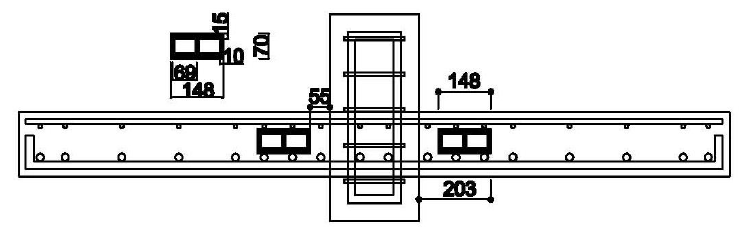
Figure 4. Arrangement of GFRP vertical grid in the G-184B specimen.